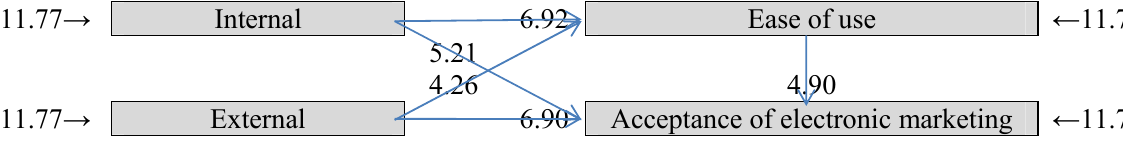
Fig. 3. The summary of the results of SEM among different components (t-student